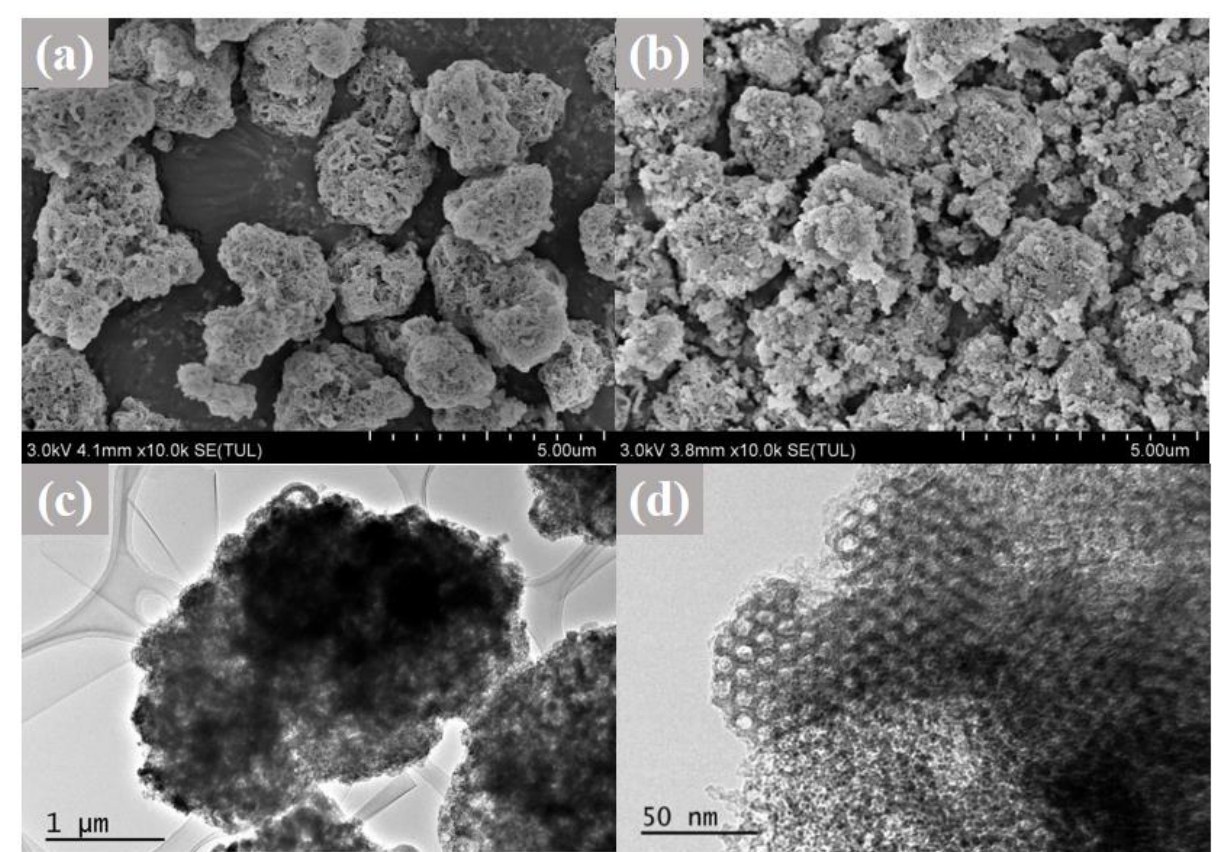
Figure 3. Scanning electron microscope (SEM) images of SNP ( a ) and CEO-SNP ( b ), and transmission electron microscope (TEM) images ( c , d ) of SNP. Table 1. Pore structural parameters of SNP.